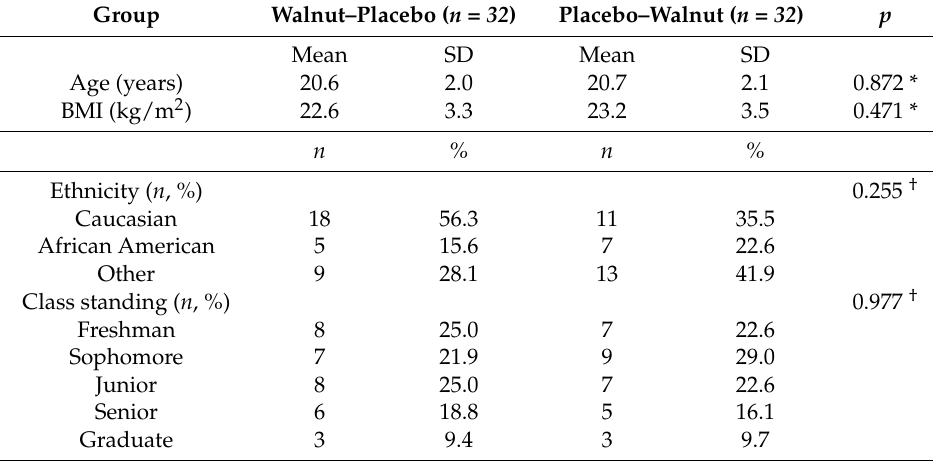
Table 3. Selected baseline characteristics of the participants by study groups. Group Walnut–Placebo ( n = 32 ) Placebo–Walnut ( n = 32 )